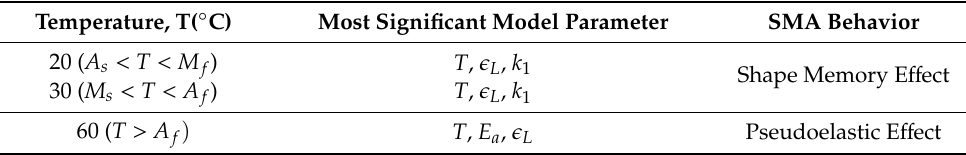
Table 5. Most influential parameters of the Ivshin–Pence